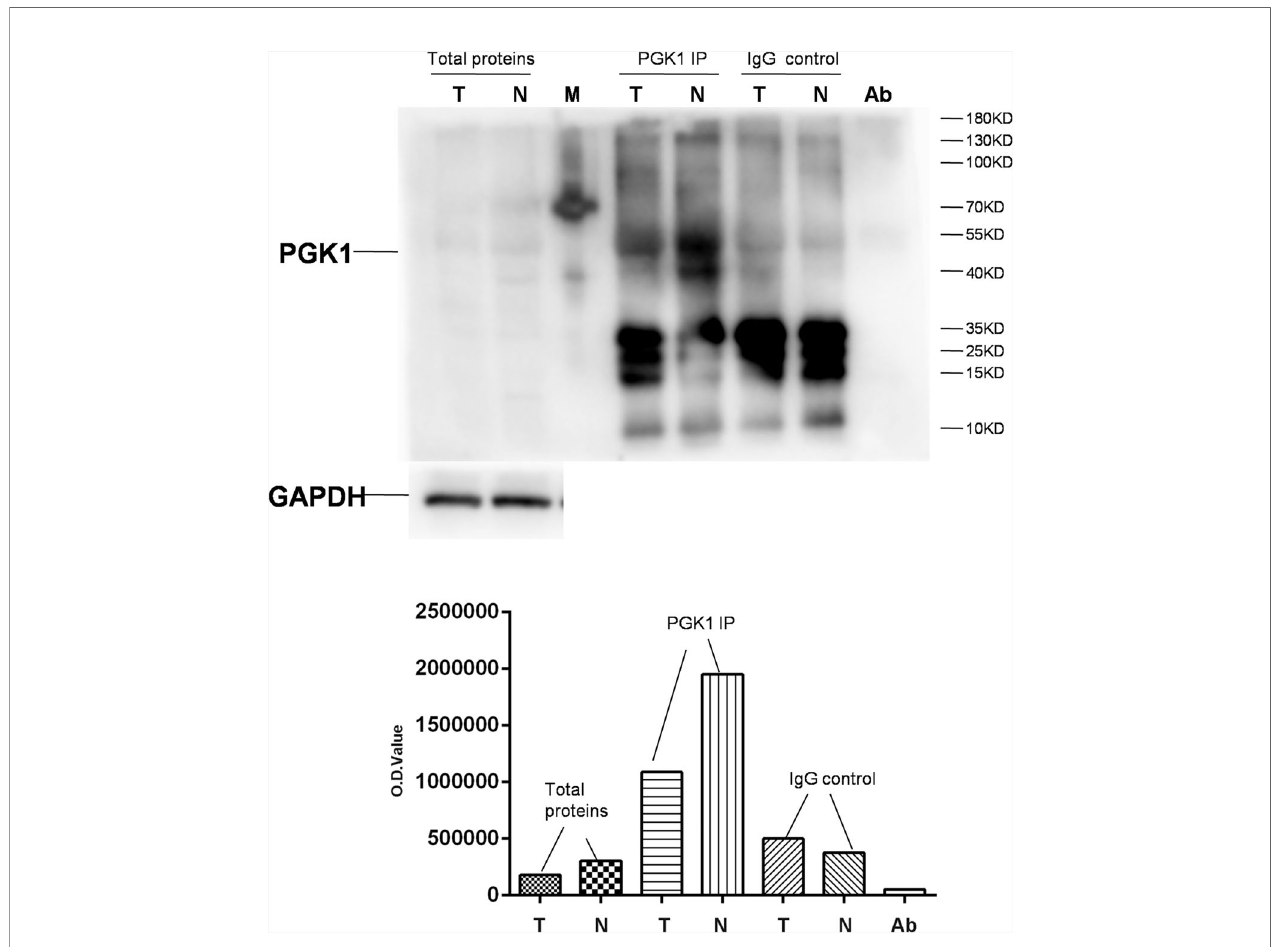
FIGURE 9 | Semiquantitative analysis of acetylated PGK1 between NF-PitNETs and controls. PGK1 in protein samples extracted from NF-PitNET and control tissues was immunoprecipitated (IP) with anti-PGK1 antibody. A negative control immunoprecipitation experiment was performed with the normal mouse IgG antibody but not anti-PGK1 antibody to test the speci fi city of anti-PGK1 antibody. The IP products (PKG1 and IgG), anti-PGK1 antibodies (Ab), and total protein samples (tumor; control) were simultaneously immunoblotted with anti-acetyl-lysine antibody. T = NF-PitNETs. N = controls. M =